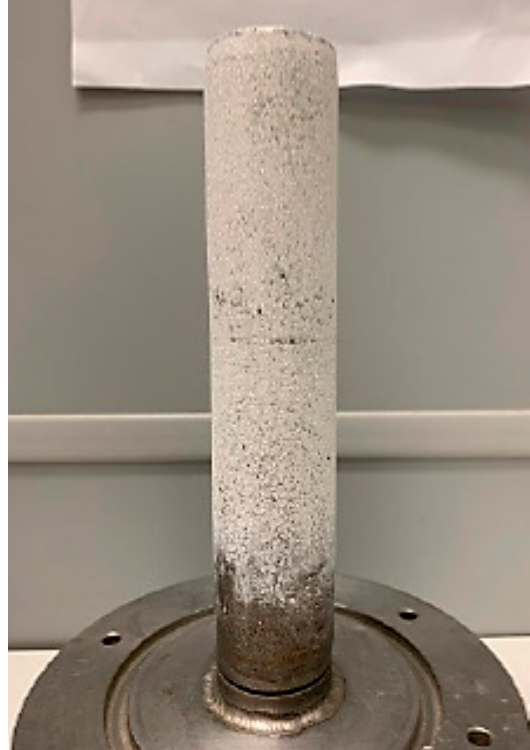
Figure 1. SAA filter covered by alginate powder.